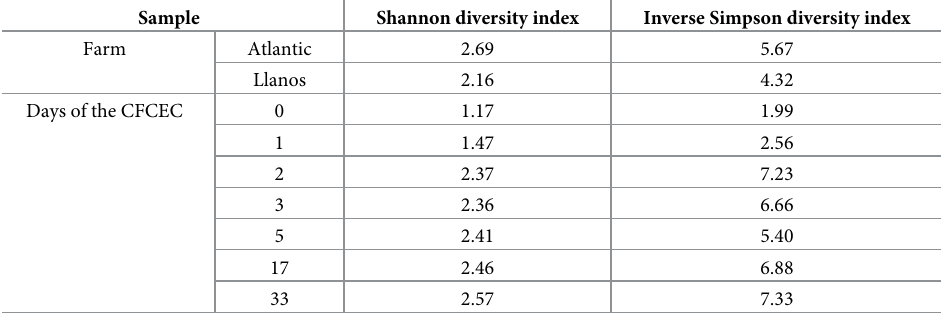
Table 2. Changes in the Shannon diversity index and Inverse Simpson diversity Index for bacteria in the intestinal contents of Nile tilapia from two farms and the continuous-flow competitive exclusion culture